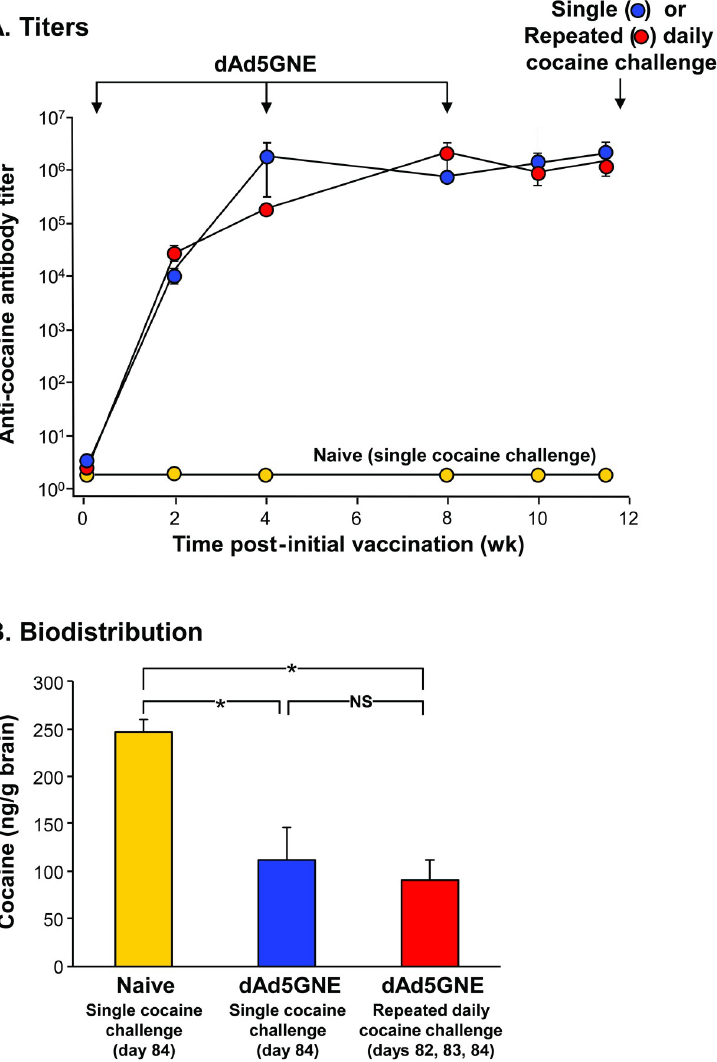
Fig 1. Vaccination with dAd5GNE evokes high titer antibodies and limits cocaine access to the brain following repeated daily cocaine use. A. Anti-cocaine antibody titer in dAd5GNE vaccinated mice. Naive animals had no detectable anti-cocaine antibody titer. B. Cocaine biodistribution following challenge with cocaine. Naive animals challenged with cocaine had high cocaine levels in the brain 1 min following a single 0.1 mg/kg cocaine challenge. dA5GNE vaccination significantly reduced cocaine levels in the brain 1 min following a single cocaine challenge. dAd5GNE vaccination also significantly reduced cocaine levels in the brain 1 min following the third of 3 repeated daily cocaine challenges. Results are shown as mean ± SE. Naive animals challenged with a single dose of cocaine are shown in yellow (n = 3). dAd5GNE vaccinated animals challenged with a single dose of cocaine are shown in blue (n = 4). dAd5GNE vaccinated animals challenged with 3 repeated daily cocaine challenges are shown in red (n = 5). Groups are compared by two-tailed unpaired t-tests ( � denotes p < 0.05, NS = not